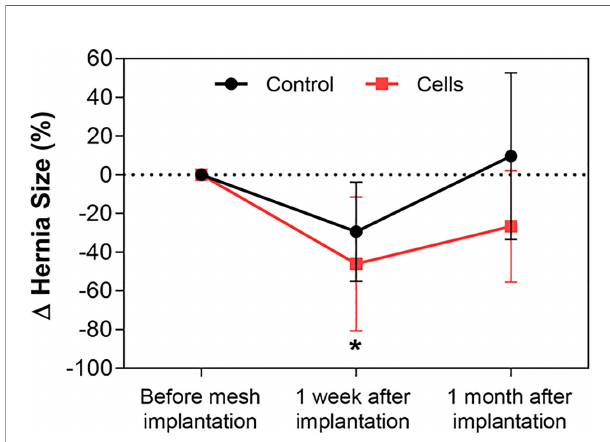
FIGURE 5 | Evaluation of hernia size by ultrasonography. The maximum diameter of the hernia ori fi ce was recorded by ultrasonography before, 1 week after, and 1 month after hernia border approximation and mesh implantation surgery in all animals in the two groups: control (black line) and cell group (red line). Changes in hernia size are presented as percent reduction at different time points, with the initial size of the hernia pertaining to the size before mesh implantation. A statistically signi fi cant decrease in the size of the hernias was observed 1 week after implantation in the cell group compared with the size recorded before mesh implantation surgery. All data are presented as mean ± standard deviation. The graph was created with GraphPad Prism. * p < 0.05 refers to the size of the hernia before mesh